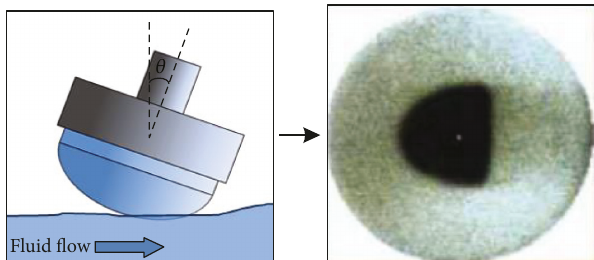
Figure 25: Polishing spot observed when stationary glass work- piece is held in rotating RMF trough for 5s [126].